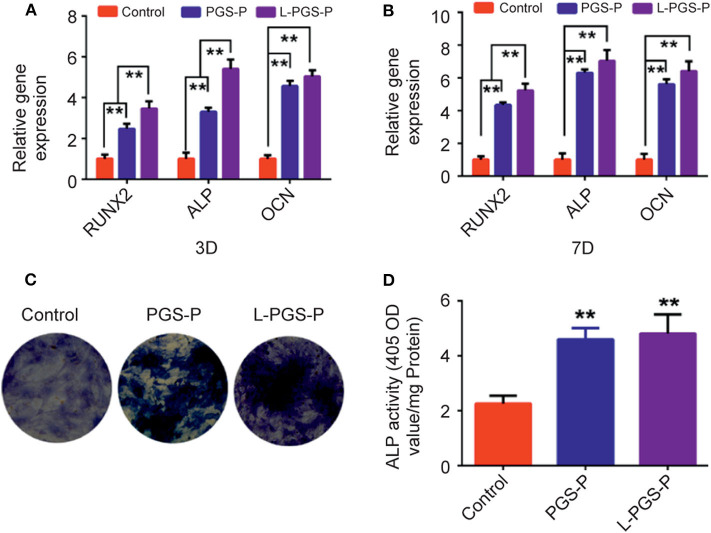
The osteogenic effects induced by PGS-P and L-PGS-P on rat bone mesenchymal stem cells. (A,B) The statistics of RT-qPCR results for RUNX2, ALP, and OCN gene expression levels which were normalized to GAPDH after 3 and 7 days of osteogenic treating. (C) rBMSCs cultured on different scaffolds in osteogenic medium for 7 days were stained for ALP examination. (D) ALP activity was assessed by quantitative method. **P < 0.01, compare with control group.